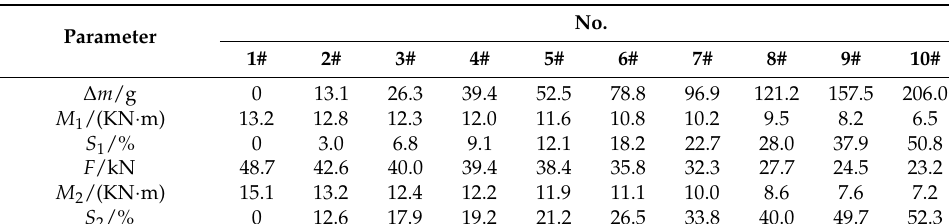
Table 4. The bending strength M of all tested beams.